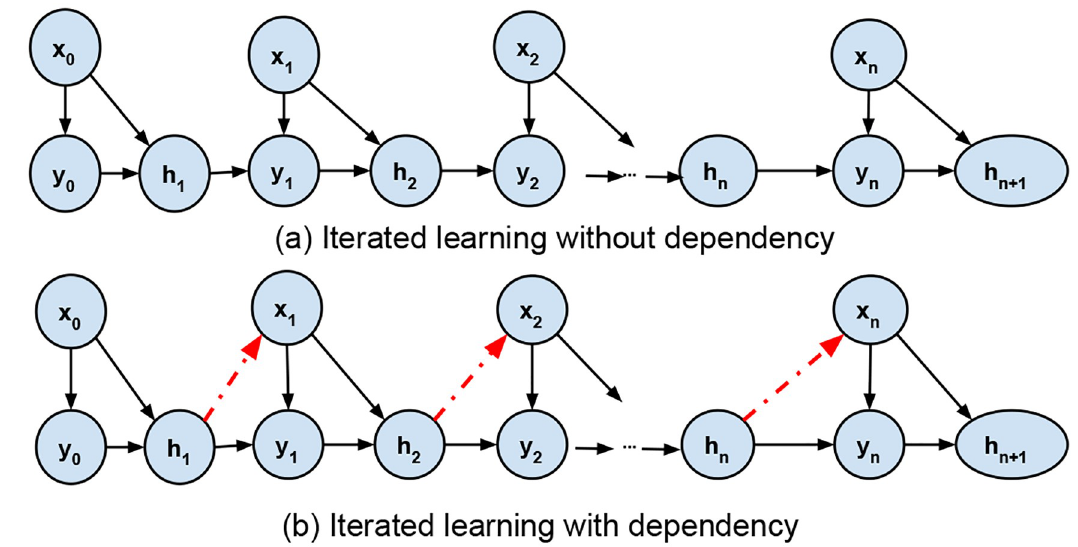
Fig 2. Markov chains for iterated learning with (bottom) and without (top) dependency from previous iterations.